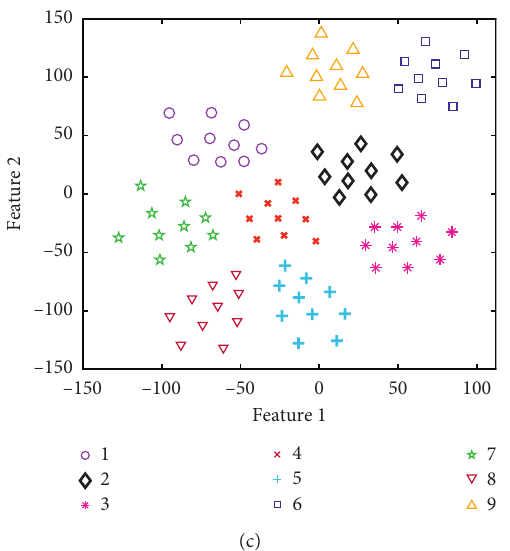
Figure 13: Two-dimensional features reduced by t-SNE using (a) 180 raw input images, (b) feature map obtained by 20 iterations of one trained network, and (c) feature maps from 10 different